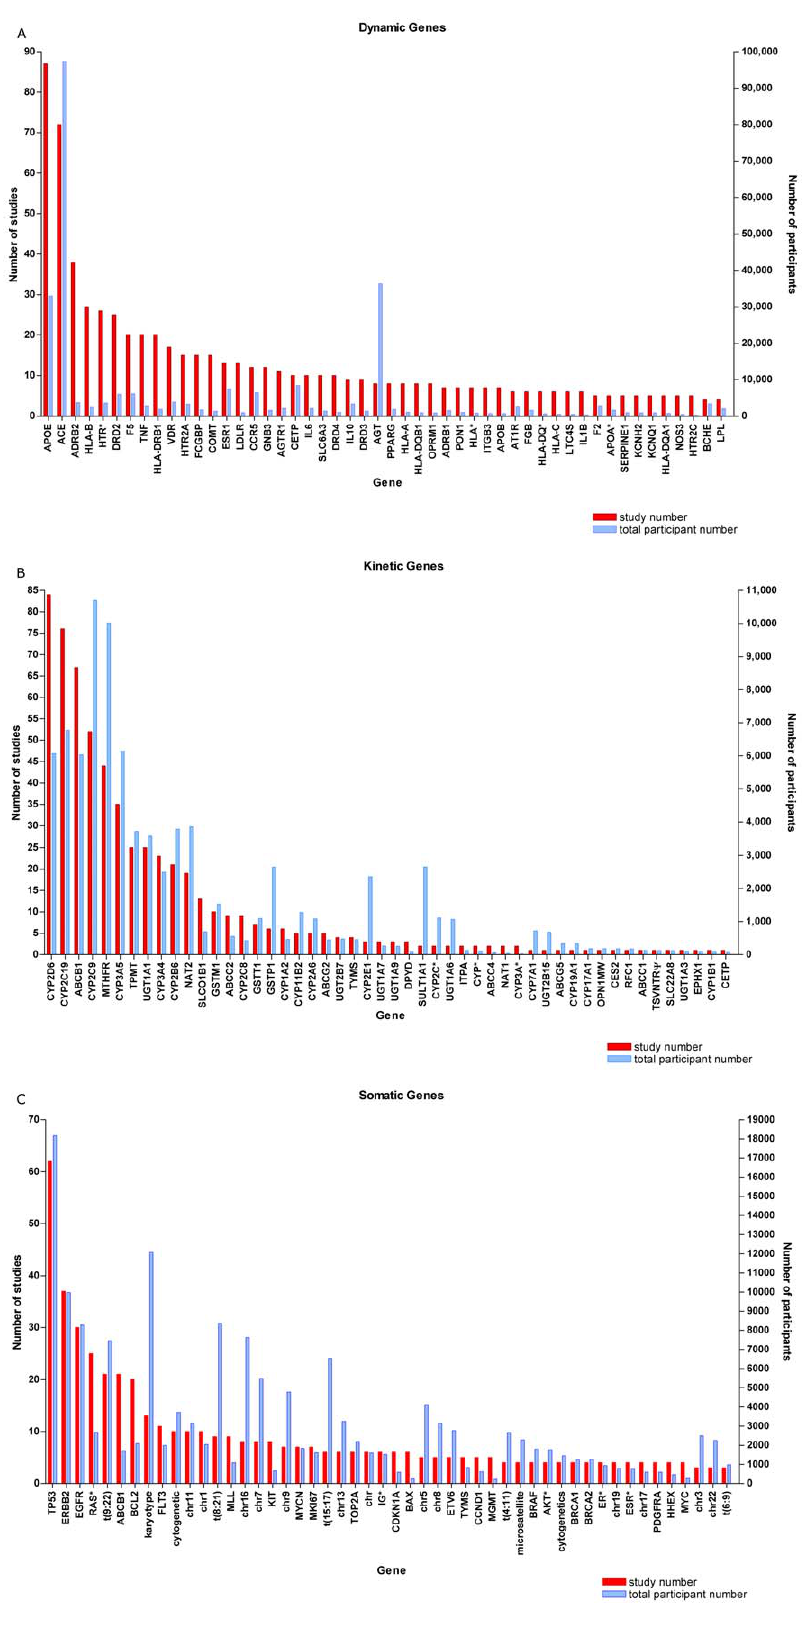
Figure 3. The 50 most frequently studied genes and the aggregate number of participants per gene. (a) pharmacodynamic genes (n=305); (b) pharmacokinetic genes (n=70); and (c) somatic genes (n=176). * refers to . 1 gene and/or non-HUGO nomenclature.